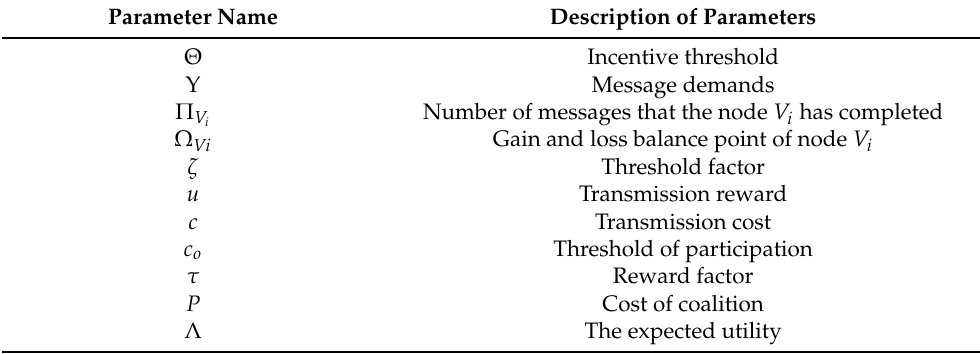
Table 2. Parameter